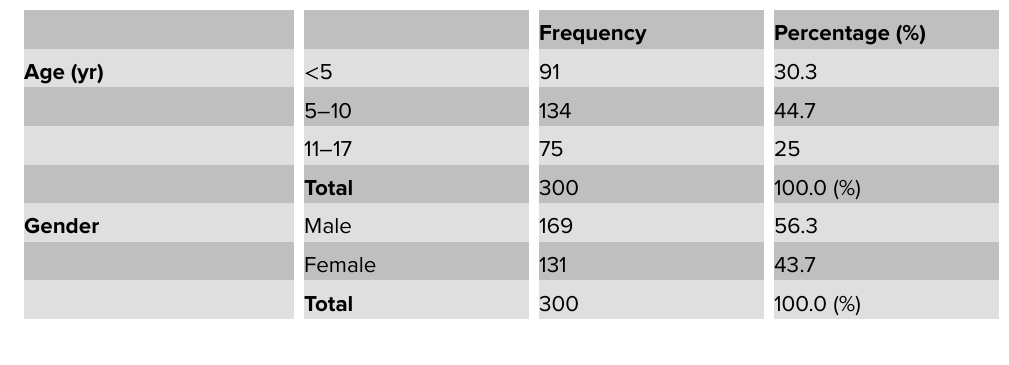
Table 1: Participant distribution according to their age and gender ( N =